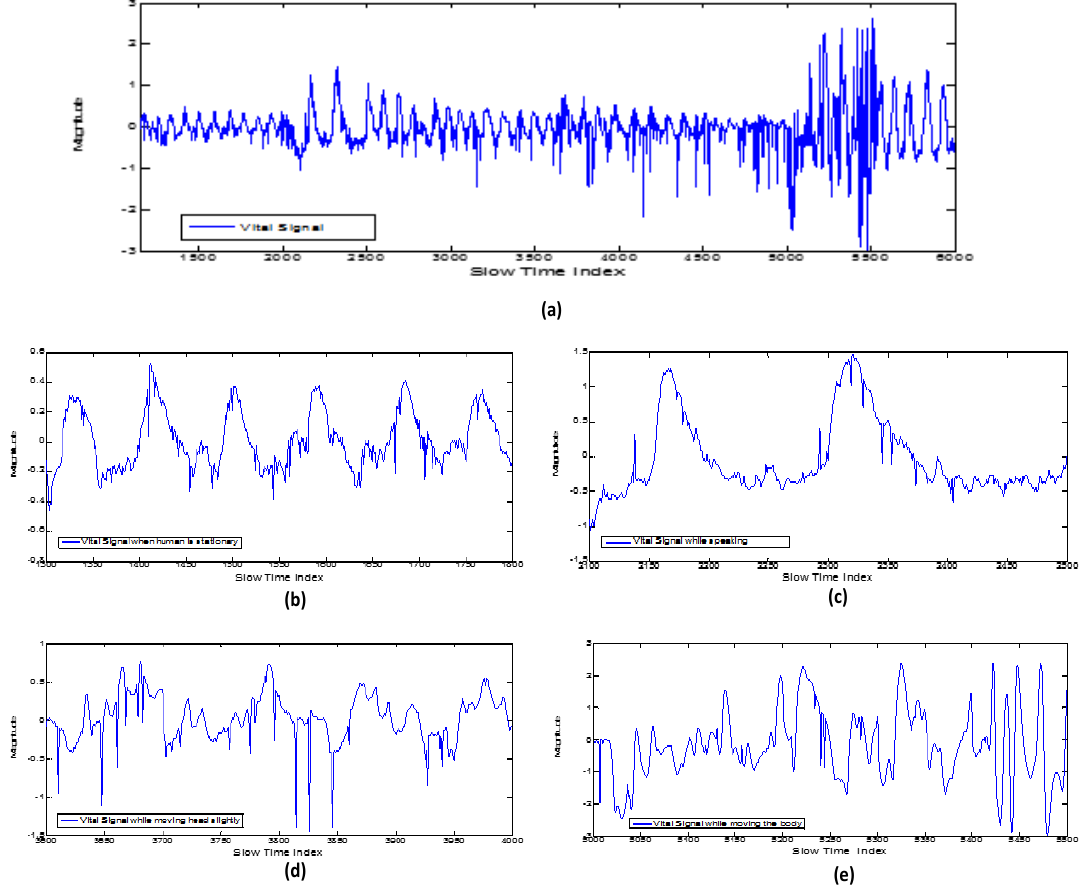
Figure 10. Vital signal obtained during different motion states of the body: ( a ) vital signal with different body states; ( b ) when body is stationary; ( c ) while speaking; ( d ) moving head slightly; ( e ) moving whole body slightly.